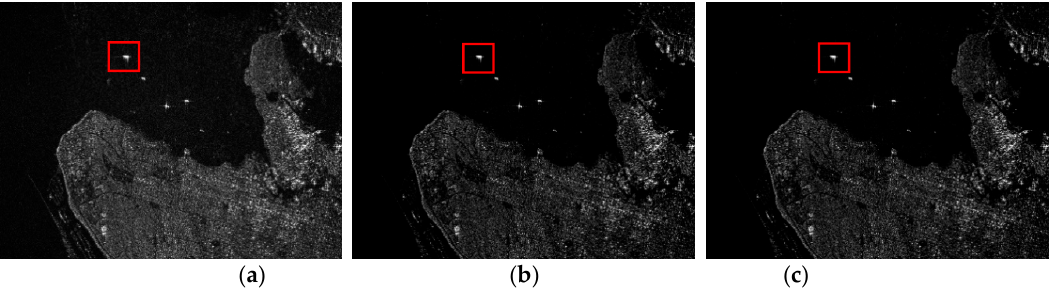
Figure 2. Images recovered from fully sampled Radarsat-1 data via different methods. (Red square indicates one ship. ( a ) Matched filtering. ( b ) Raw data-based sparse imaging method. ( c ) Complex image-based sparse imaging method.